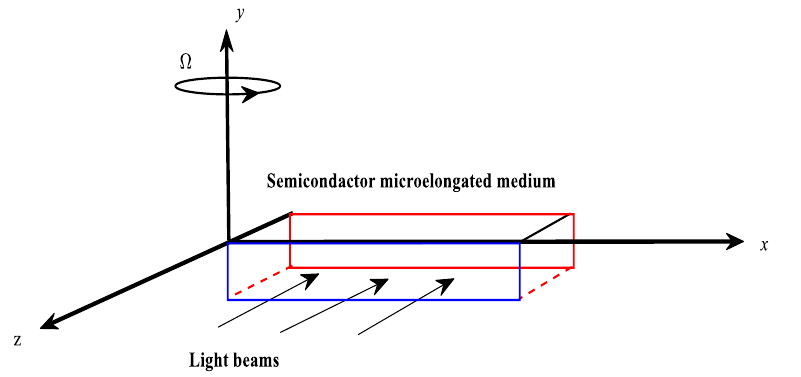
Figure 1. The geometry of the Figure 1. The g eometry of the problem.